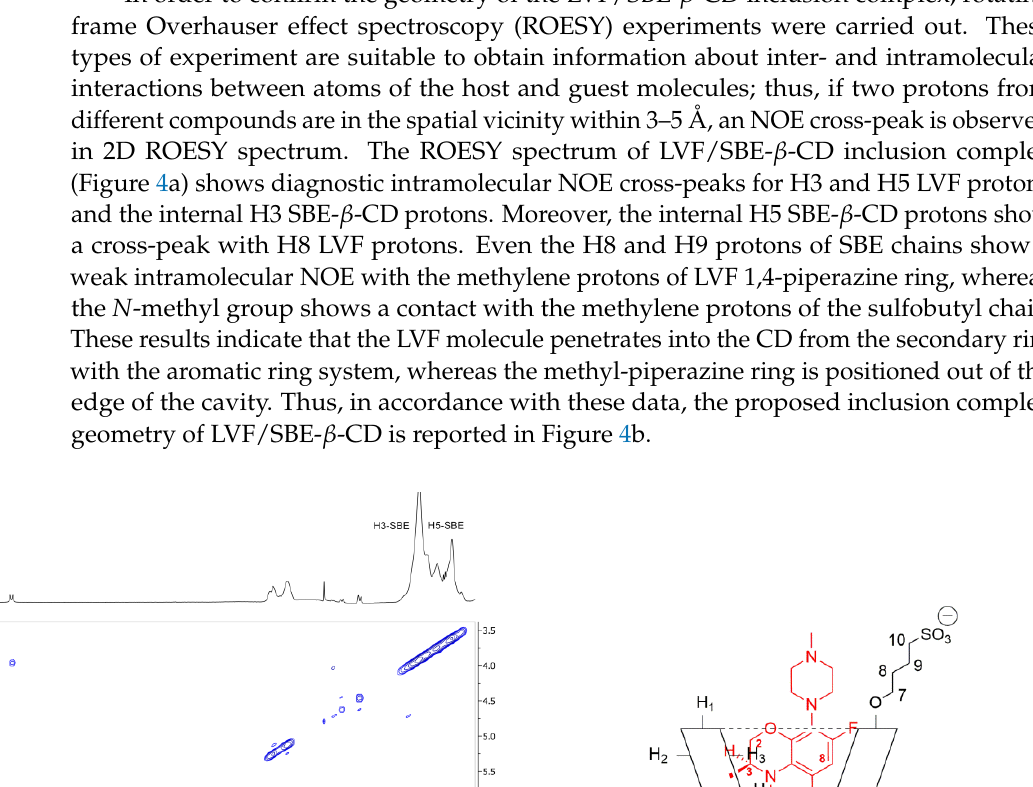
the displacement of the solid lines with respect to the corresponding dashed ones (Figure 5) allows a quantitative estimate of the complex formation constant. These results point out that the diffusion coefficient for the LVF diminished considerably (from 4.13 to 3.45 × 10 − 10 m 2 /s), and this is indicative of a strong complexation within the SBE- β -CD cavity; analogously, the diffusion coefficient of the SBE- β -CD also diminished, but slightly (from 1.96 to 1.92 × 10 –10 m 2 /s). Figure 5. 2D DOSY-NMR measurements on the 10 mM D 2 O solutions of LVF, SBE- β -CD, and LVF/SBE- β -CD 1:1 inclusion complex. The horizontal axis represents the chemical shifts, whereas